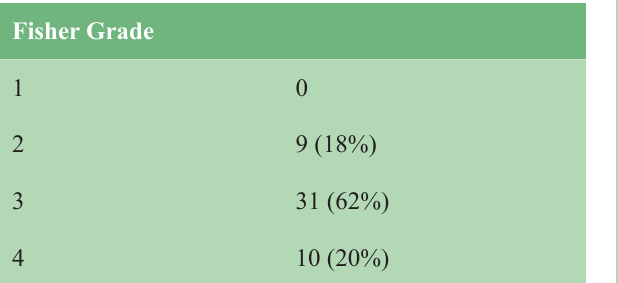
Table 2. Fisher Grade of SAH Patients